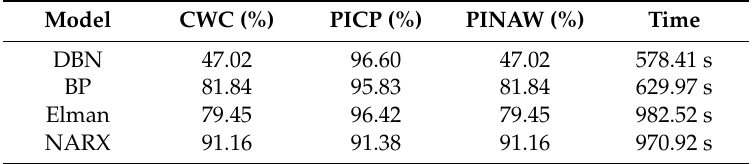
Table 3. Comparative results of the four models in terms of different